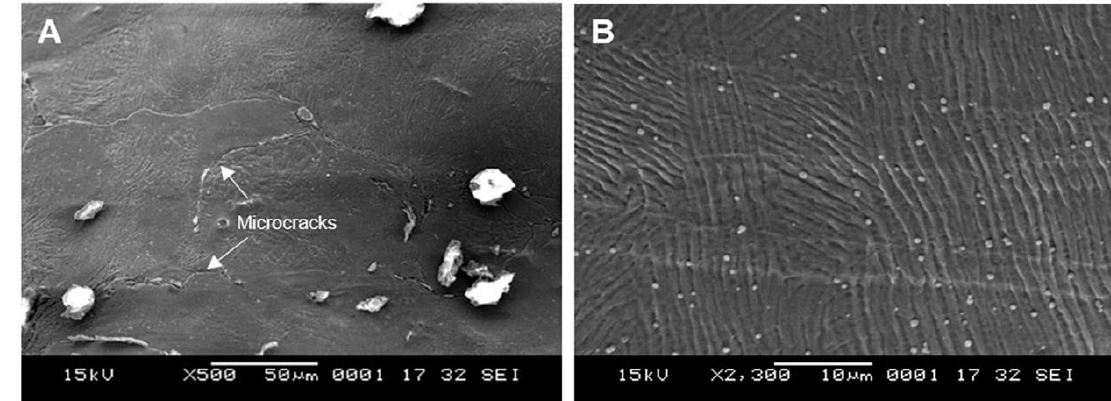
Figure 15. Scanning electron micrographs of the lattice following sandblasting, abrasive polishing and electropolishing (experiment 2B). Compared to experiment 1B, there were ( A ) shallower microcracks formed. and ( B ) fewer residual particles.